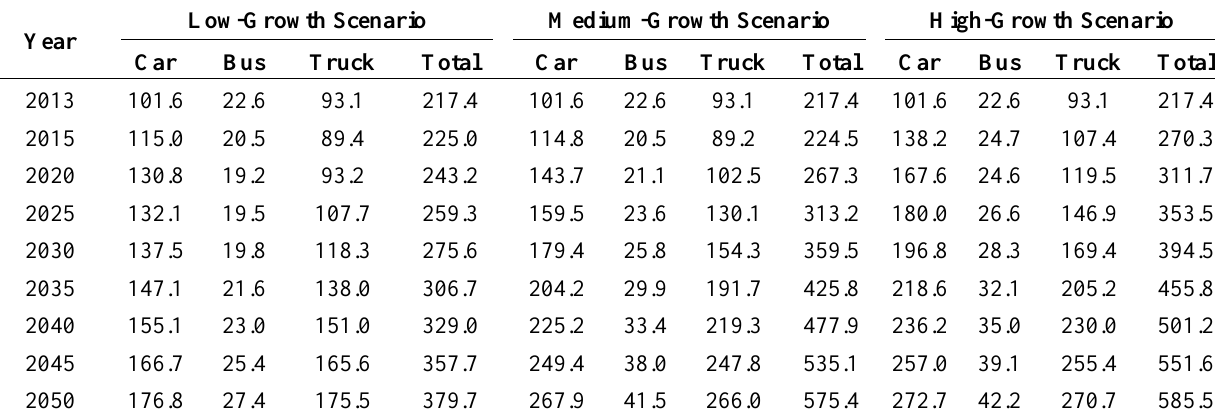
Table 5. Energy consumption of road vehicles in China (Unit: